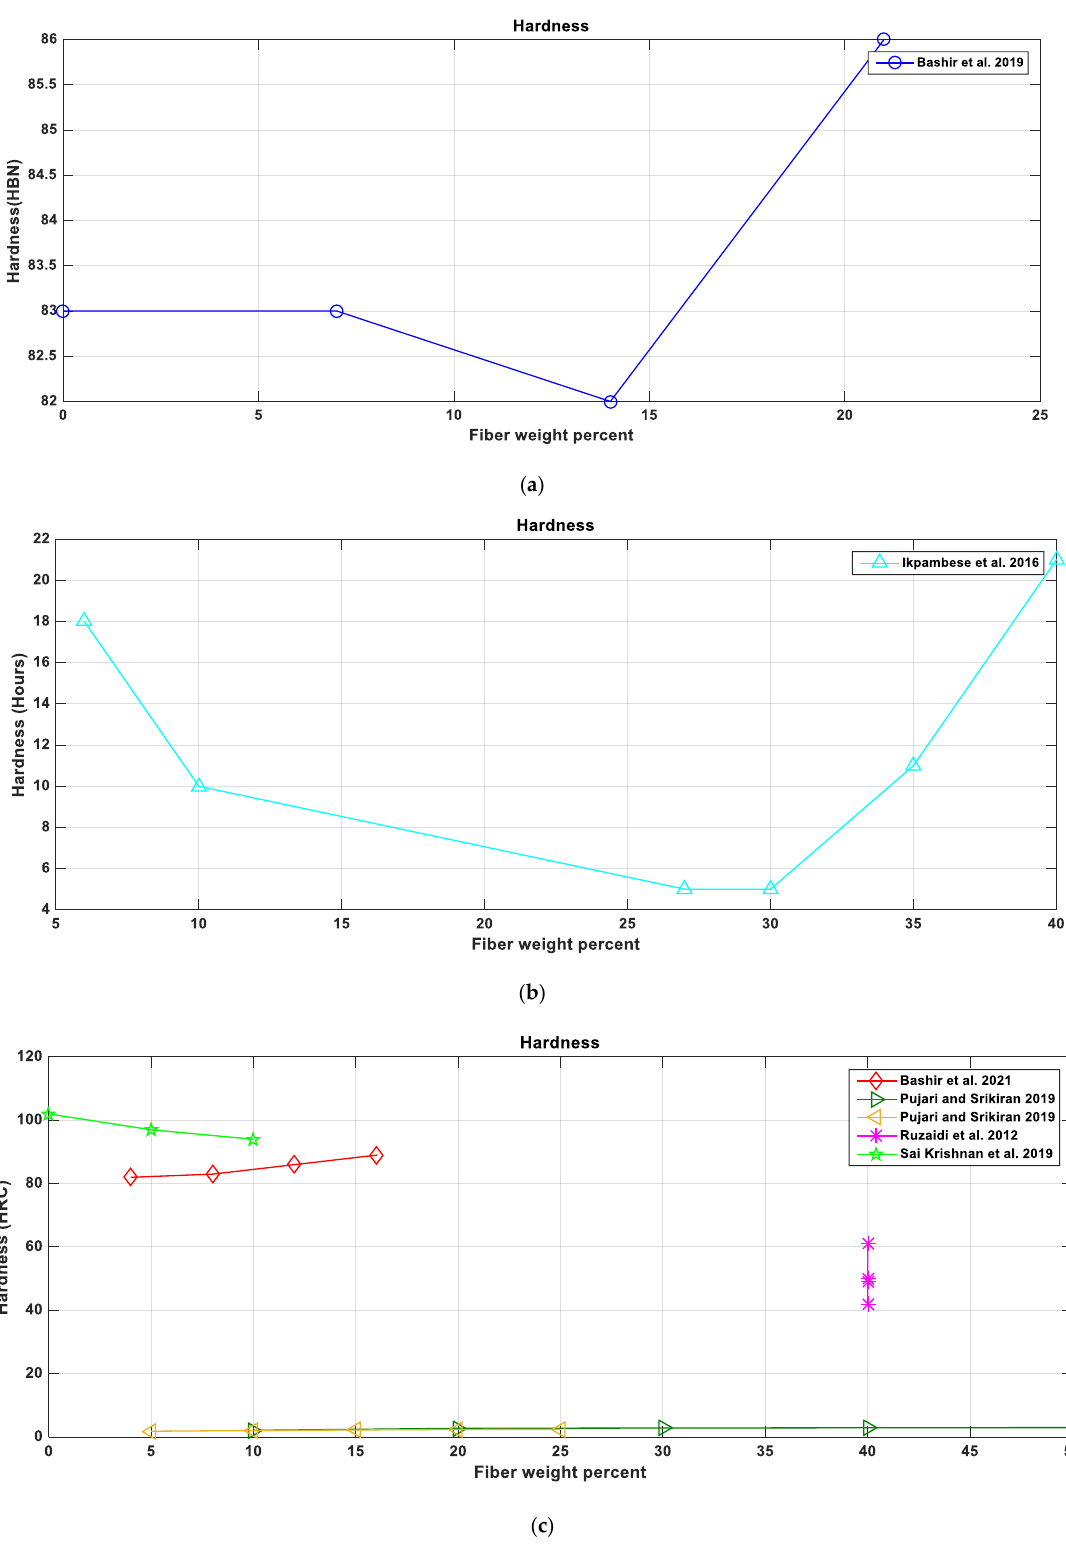
Figure 6. The variation of COF for different fibers with a variation in the fiber weight percentage [43,44,56,67].